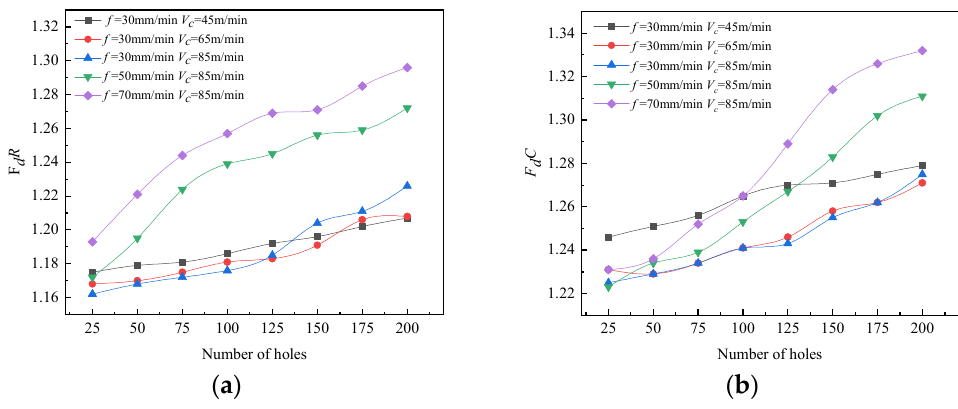
Figure 12. Effect of tool wear on the delamination factors: ( a ) entrance delamination factors; ( b ) exit delamination factors.